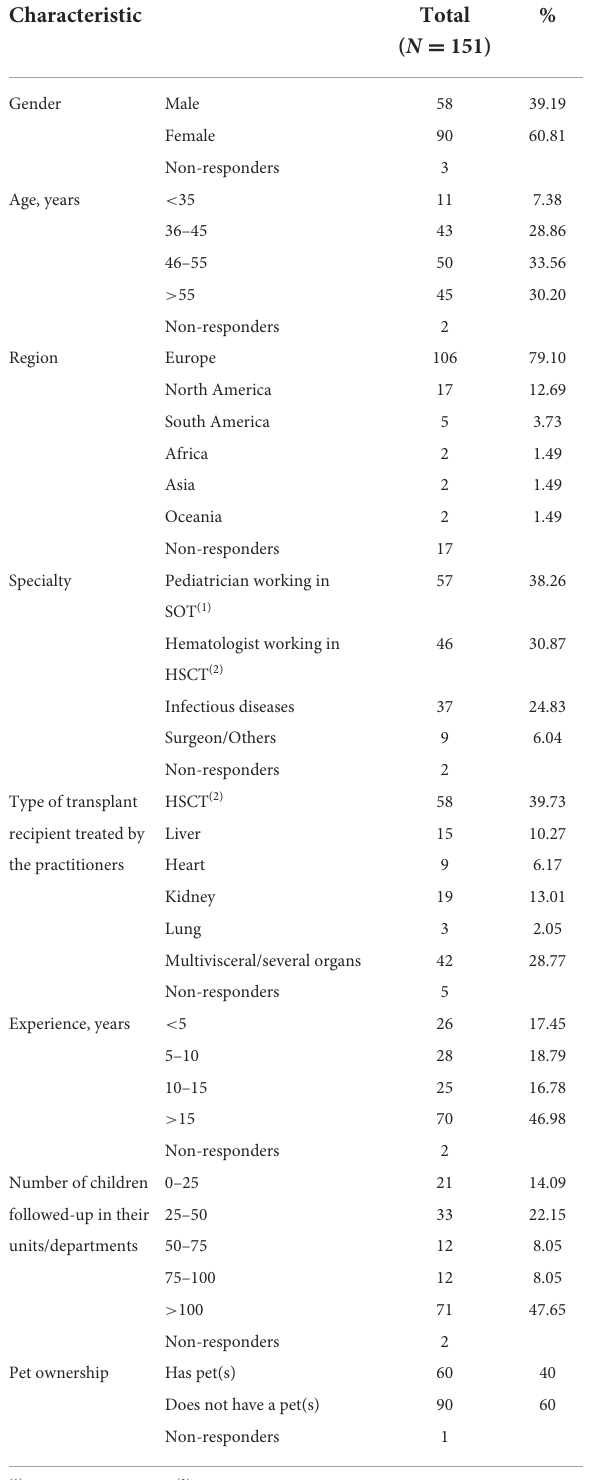
TABLE 1 Demographic characteristics of the